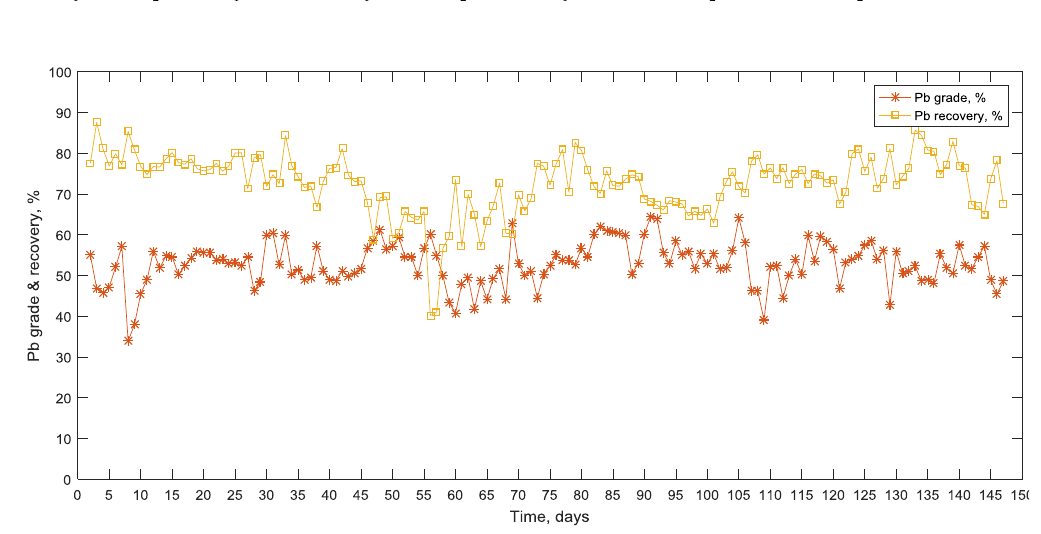
Figure 7. Daily grade and recovery data for lead flotation plant.